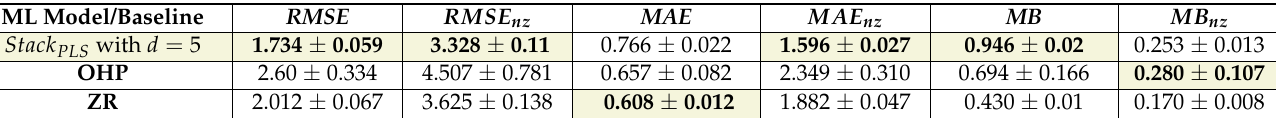
Table 4. Comparison between the results of the Stack PLS regressor and the OHP and ZR baselines. 95% CIs are used for the results. The best values for the performance metrics are marked with bold. ML Model/Baseline RMSE RMSE nz MAE MAE